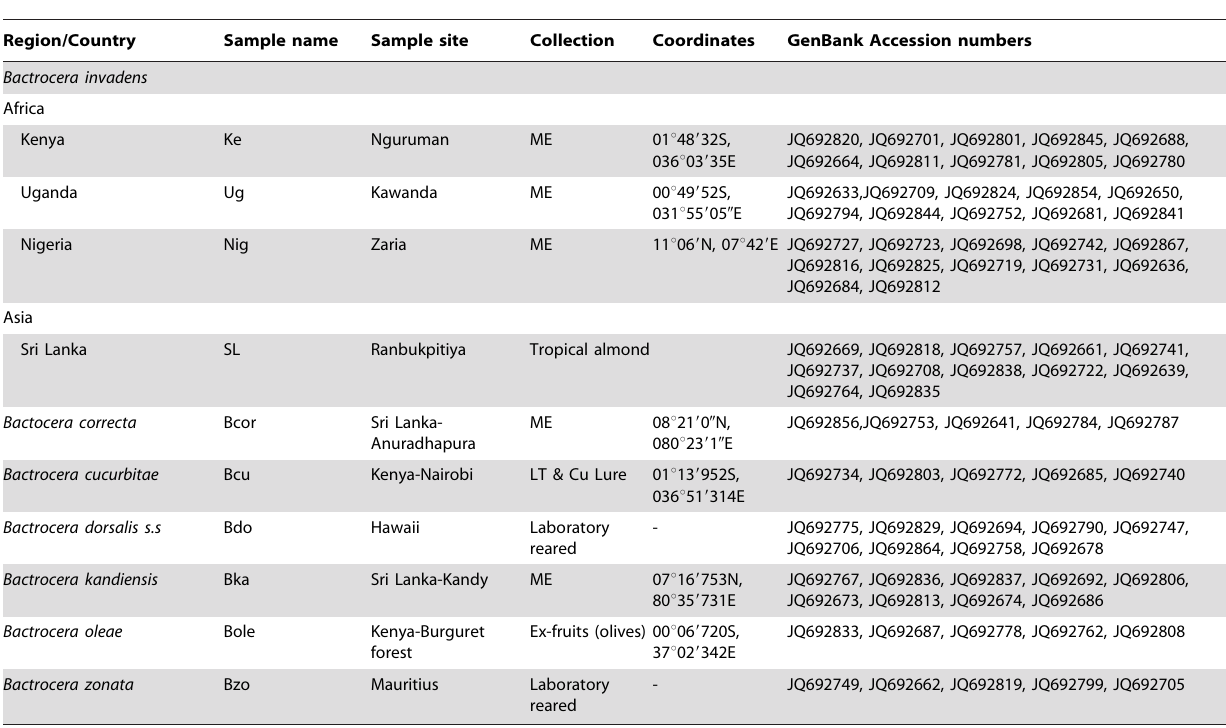
Table 6. Collection data of B. invadens populations and other Bactrocera species used in this study.